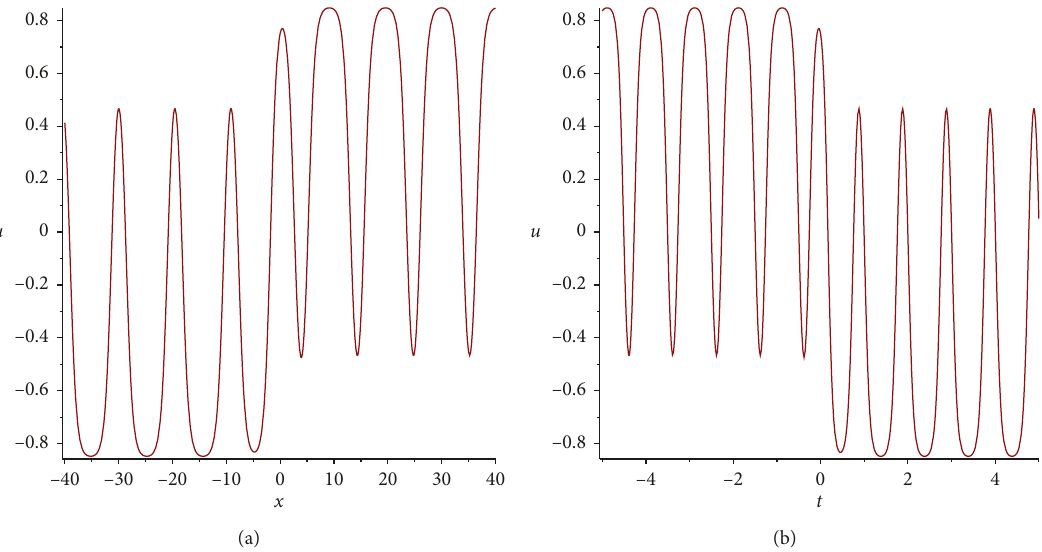
0; (b) two-dimensional plot (cid:29)